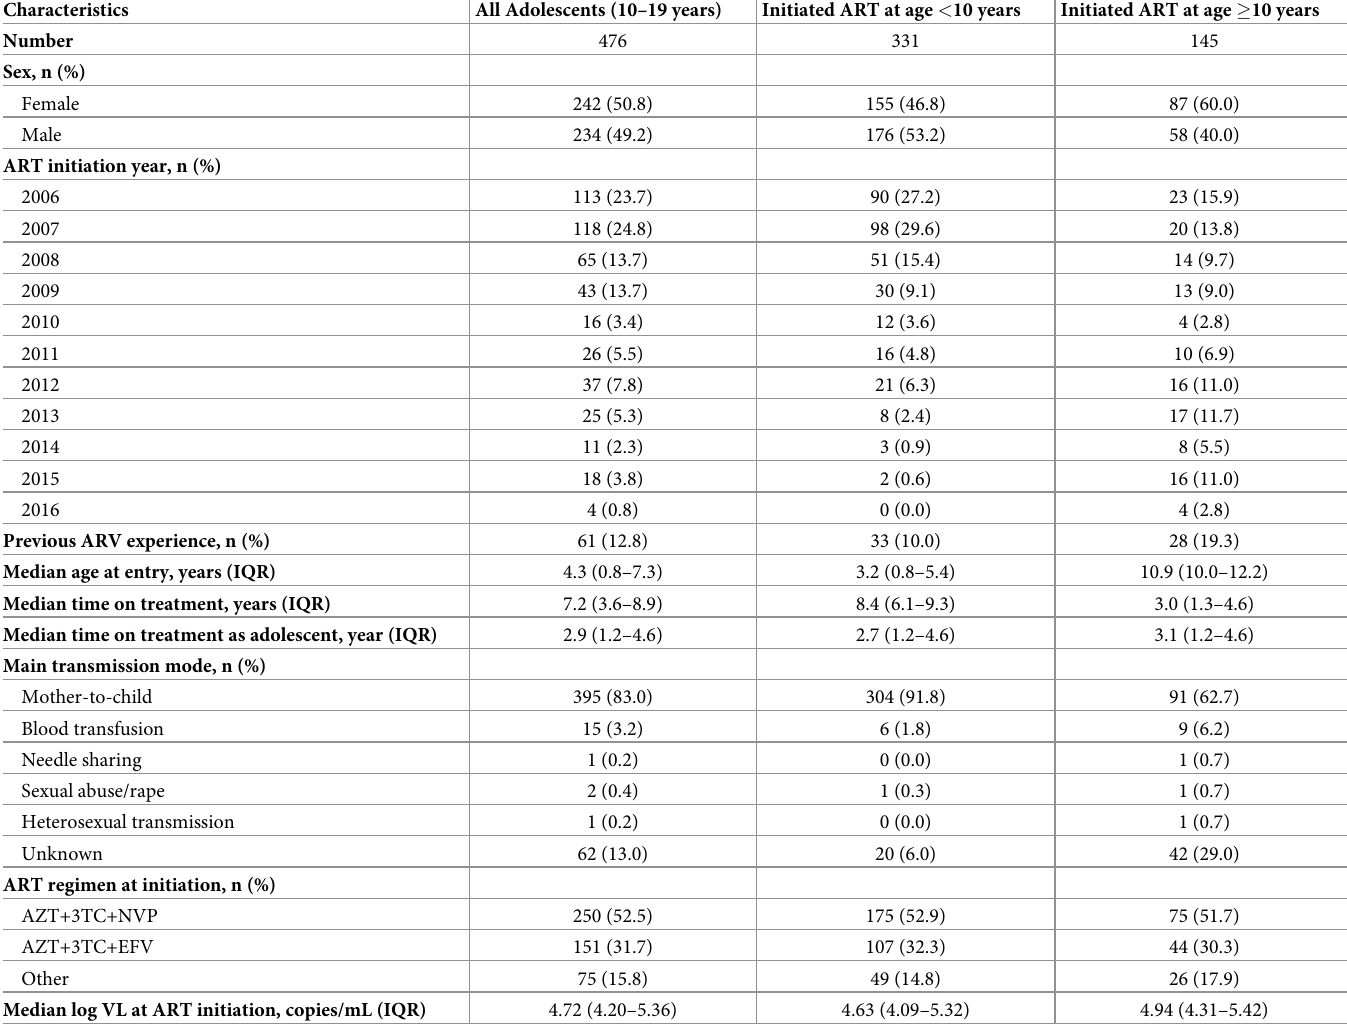
Table 1. Demographic characteristics of adolescent population, by period of program